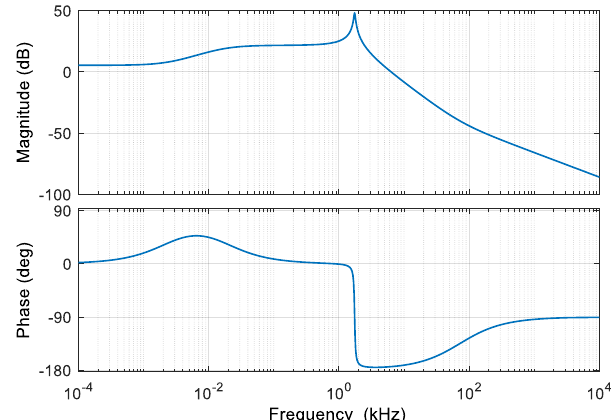
Figure 18. Bode plots of G vd ( s ) for { f s = 110 kHz, V 2 dc = 14 V}.